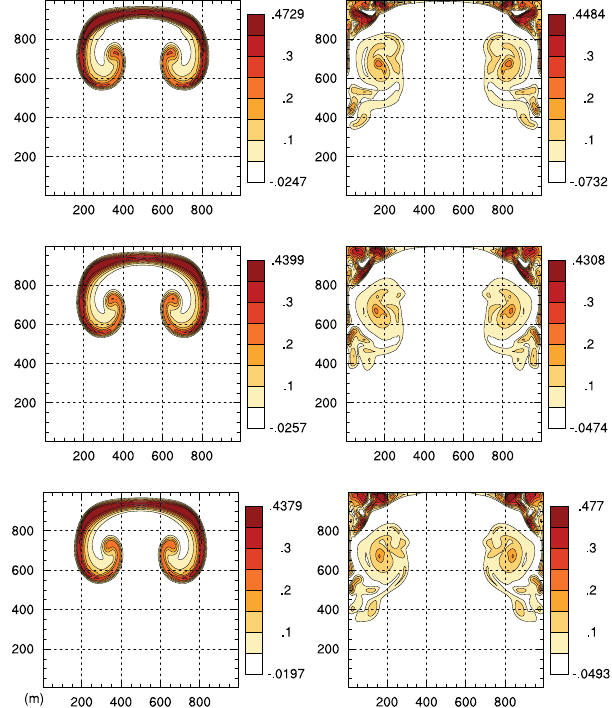
Figure 18. Rising thermal bubble potential temperature at vertical orders 2, 4, and 10. Convection bubbles at 700 and 1200s. Coarse tour interval: 0 . 05K